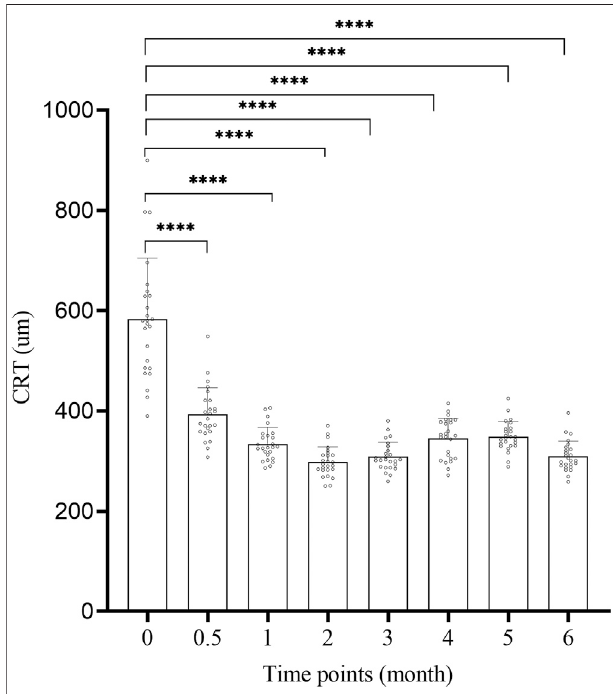
FIGURE 2 | The CRT change of each time. CRT: central retinal thickness.0:pre-op,0.5: 2wpost-op, 1:1 m post-op, 2:2 mpost-op,3: 3 m post-op, 4: 4 m post-op, 5: 5 m post-op, 6: 6 m post-op. ****: Comparison between two time points p <